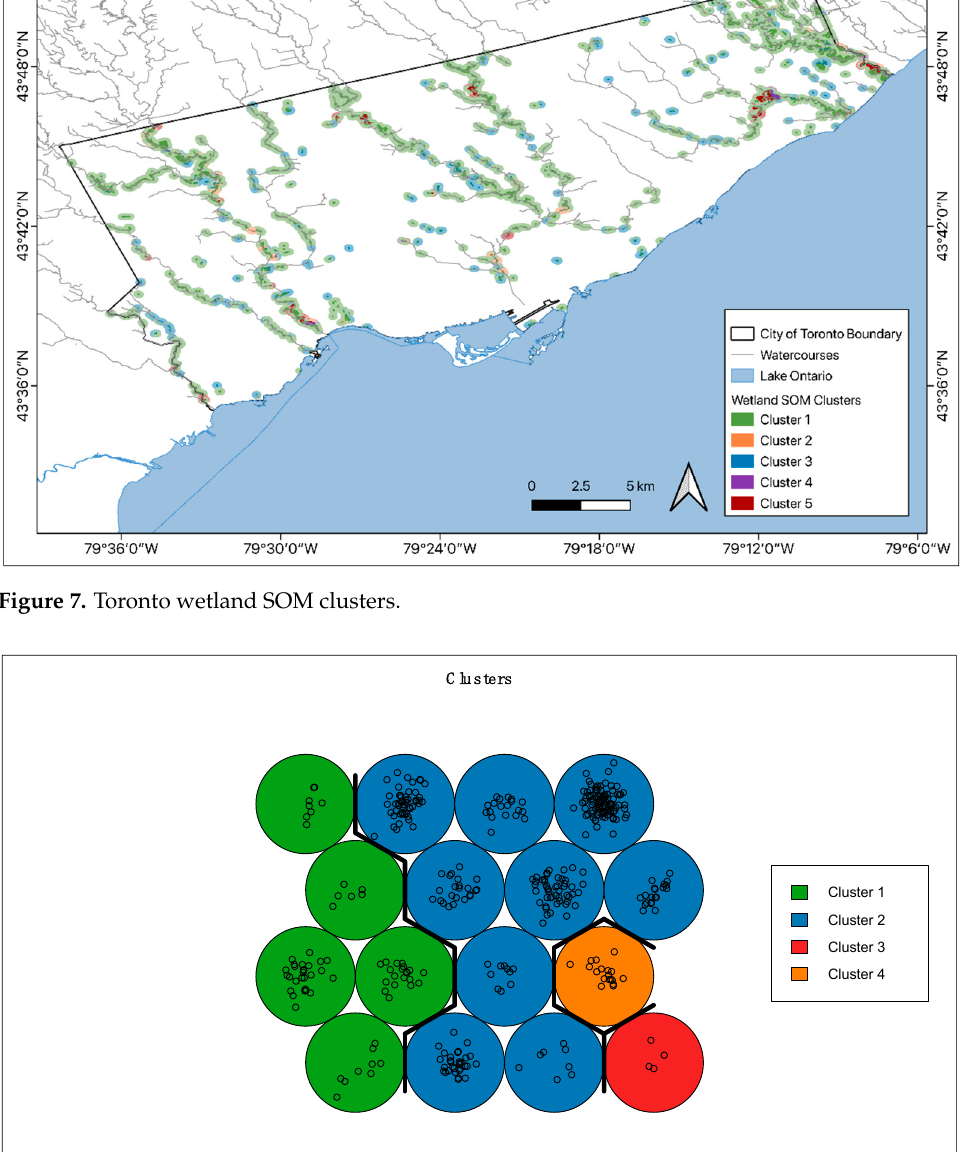
Figure 8. Chicago SOM clusters.